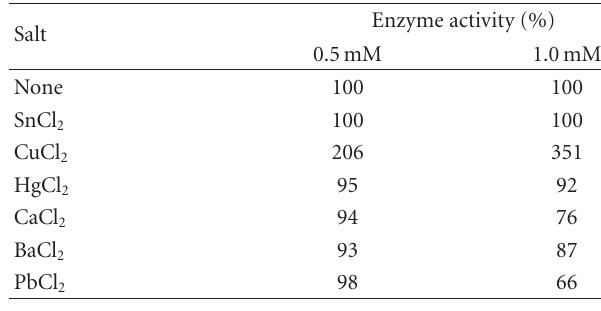
Table 3: E ff ect of cations on rainbow trout liver rhodanese activity.